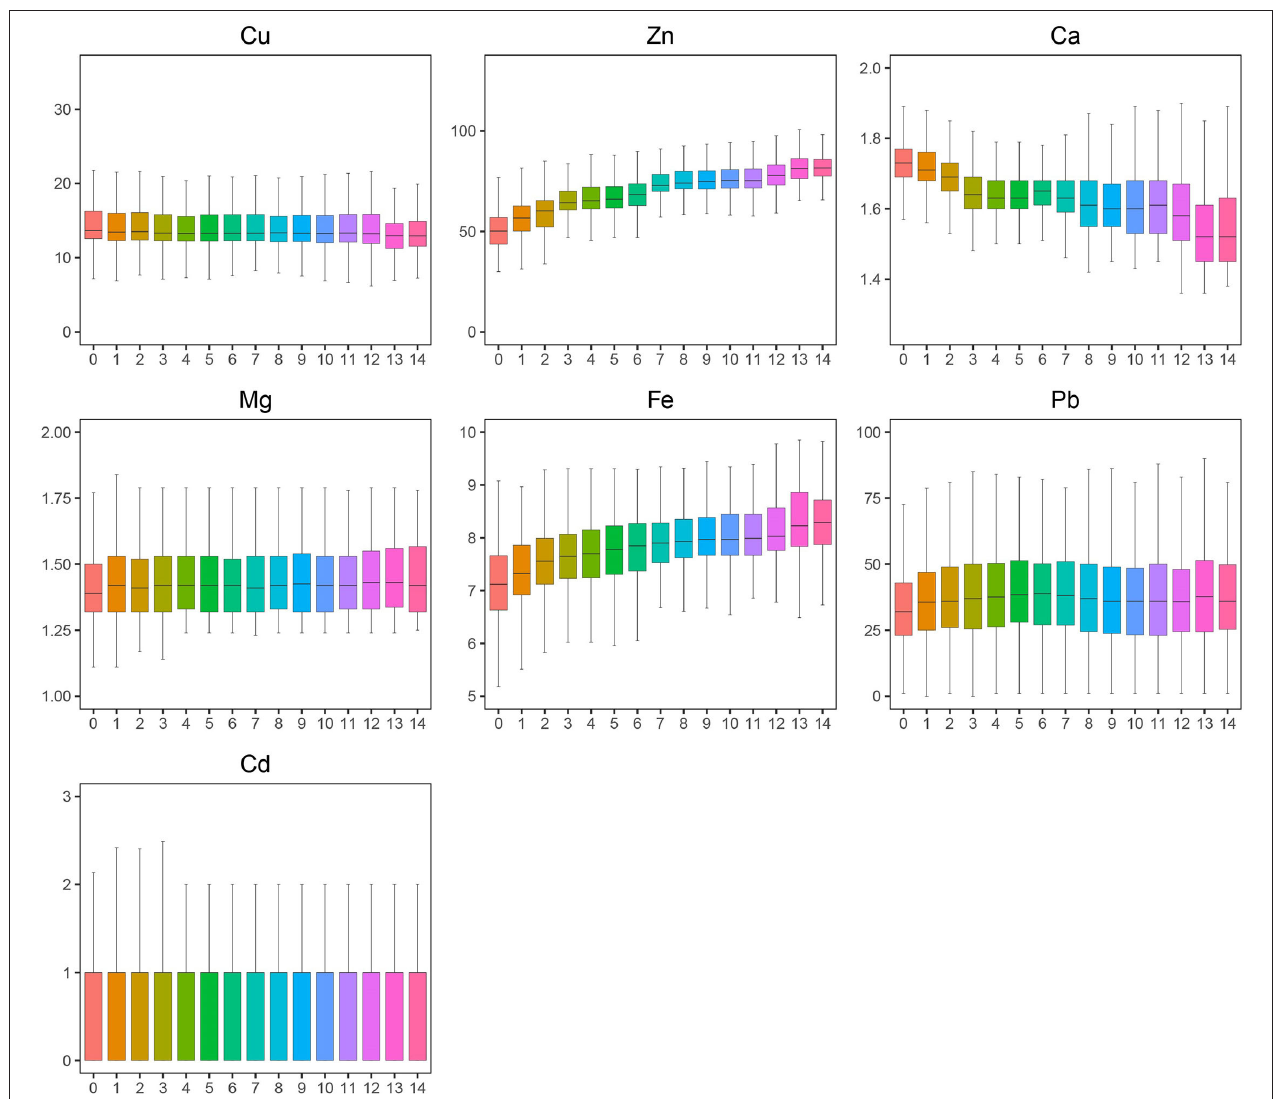
FIGURE 1 | A trend of toxic and essential element levels in the blood from 0 to14 years old. The boxplot showed the median values of elements and their percentile